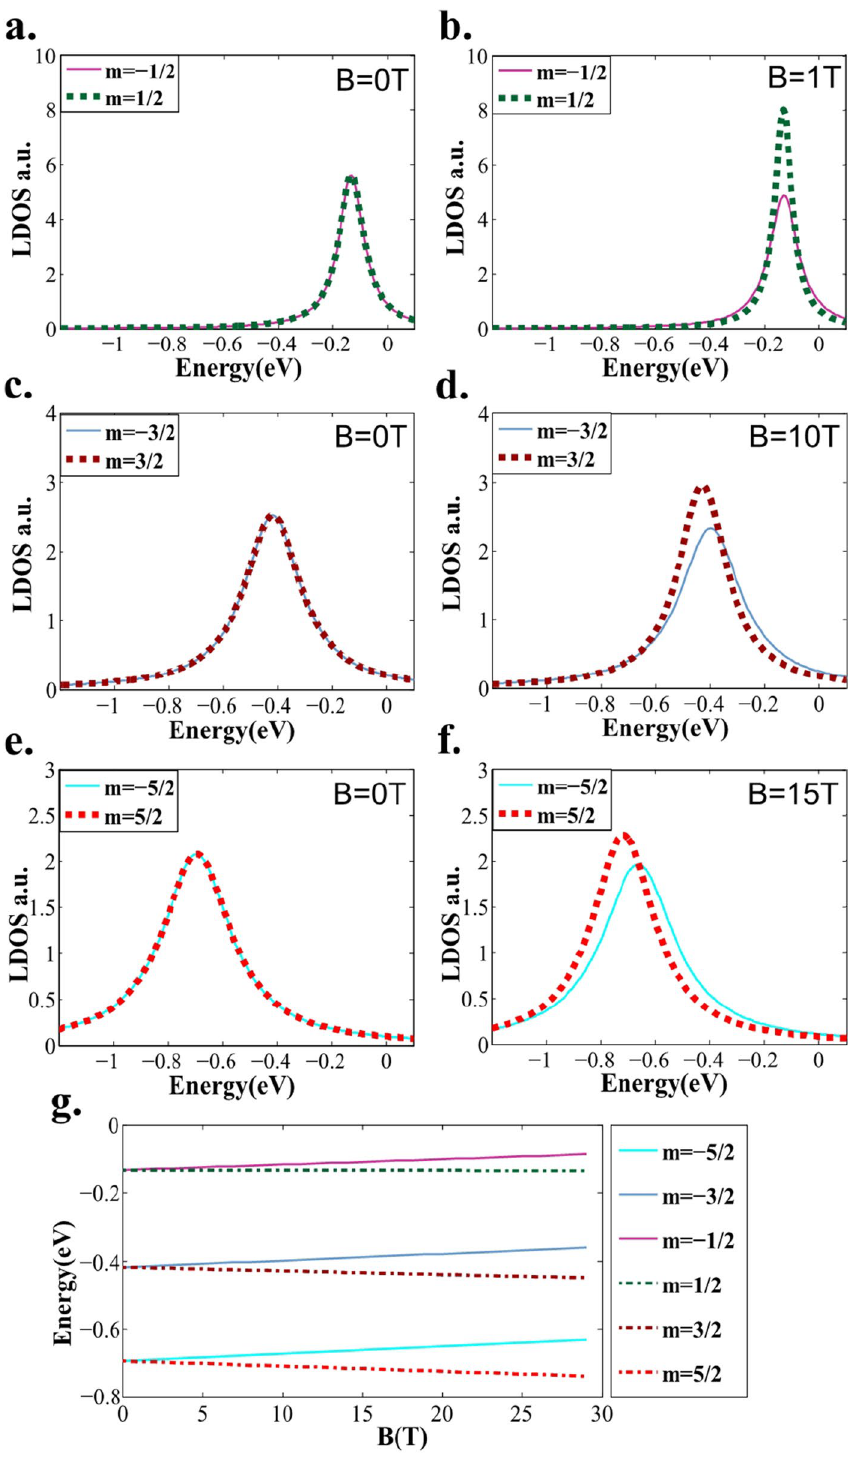
Figure 3. LDOS and energy spectra of quasi-bound states calculated by the WKB approximation. The 1 / 2, 3 / 2, and 5 / 2 . . . states of the graphene quantum dot with quasi-bound energy levels of the m = ± ± ± 4 nm , V 0 0.42 eV , E 0.09 eV depend on the magnetic field strength B . Panels (a)–(f) show the R D = − = = 1 / 2, B 0 , WKB-approximated LDOS inside the graphene quantum dot under different B fields: ( a ) m = ± = 1 / 2, B 1T , ( c ) m 3 / 2, B 0 , ( d ) m 3 / 2, B 10T , ( e ) m 5 / 2, B 0 , and ( b ) m = ± = = ± = = ± = = ± = 5 / 2, B 15T . Panel ( g ) plots the peak values in the energy spectra as B changes from 0 to ( f ) m = ± = 30T, m 1 / 2, 3 / 2, and 5 / 2 = ± ± ±